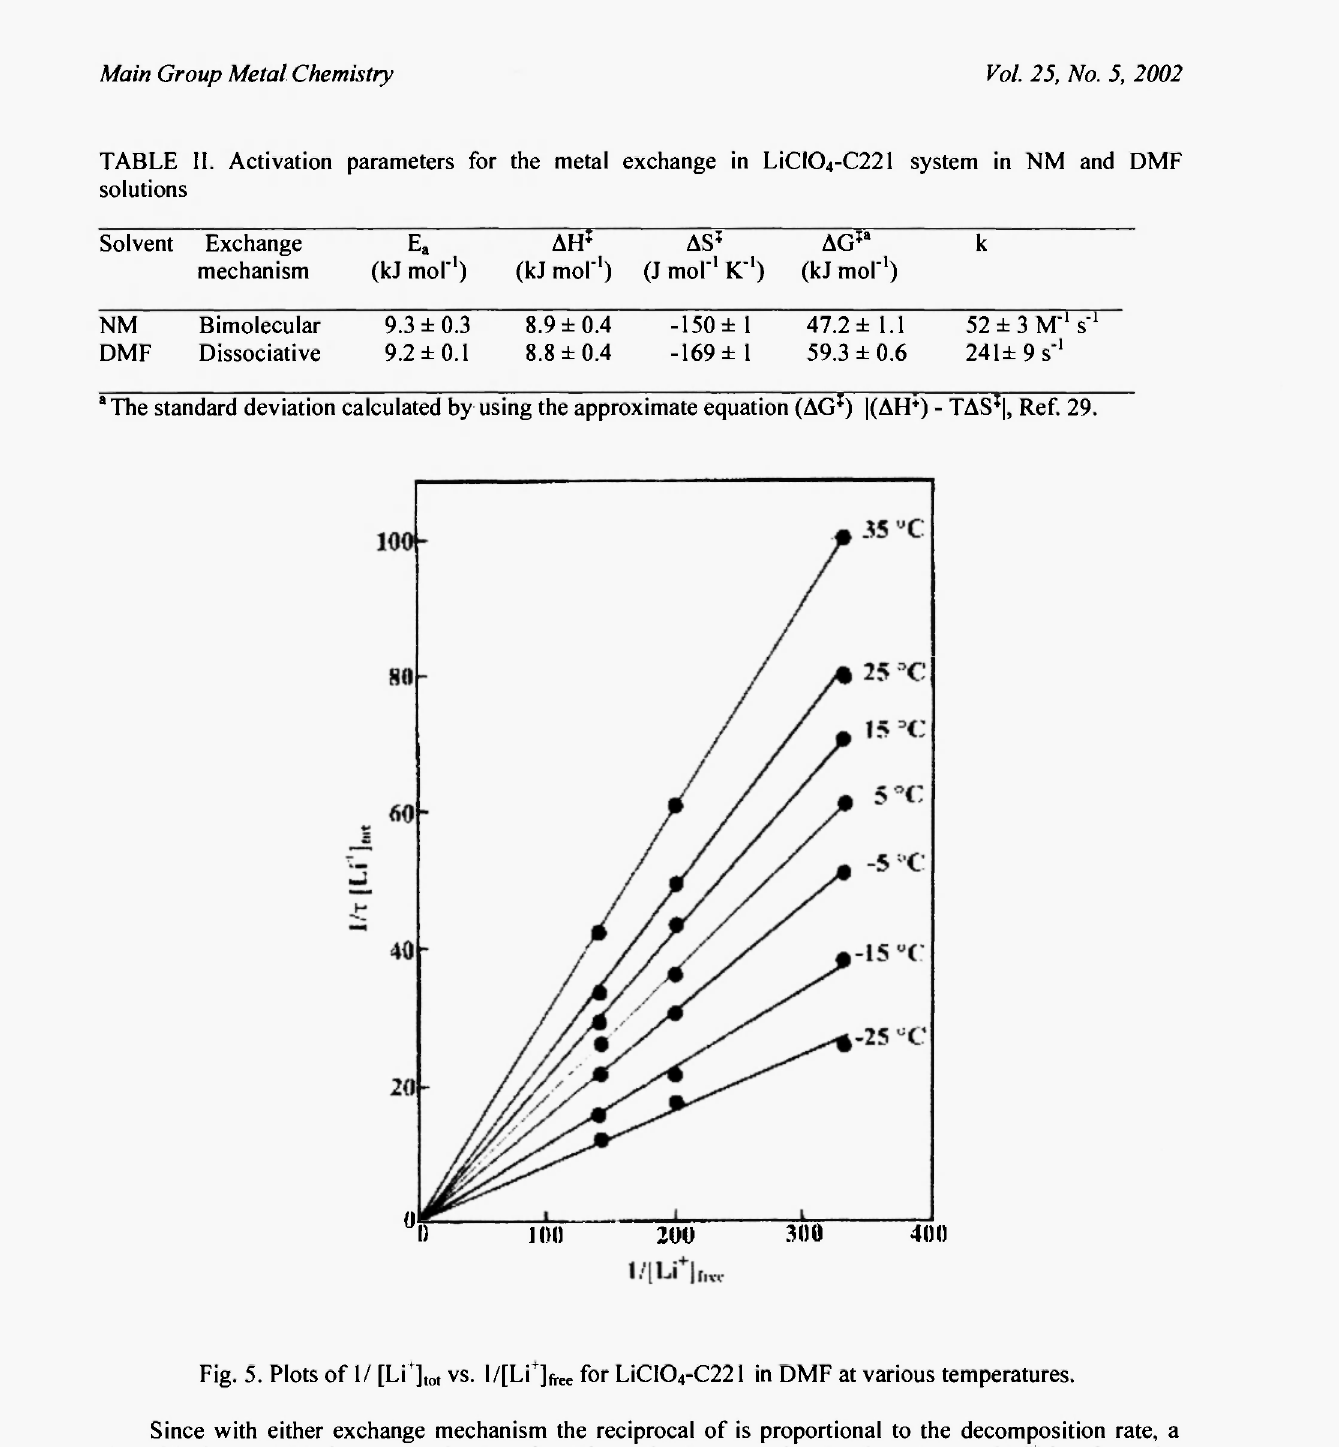
Fig. 5. Plots of 1/ [Li + ], ot vs. l/[Li + ]fr ee for LiCI0 4 -C221 in DMF at various